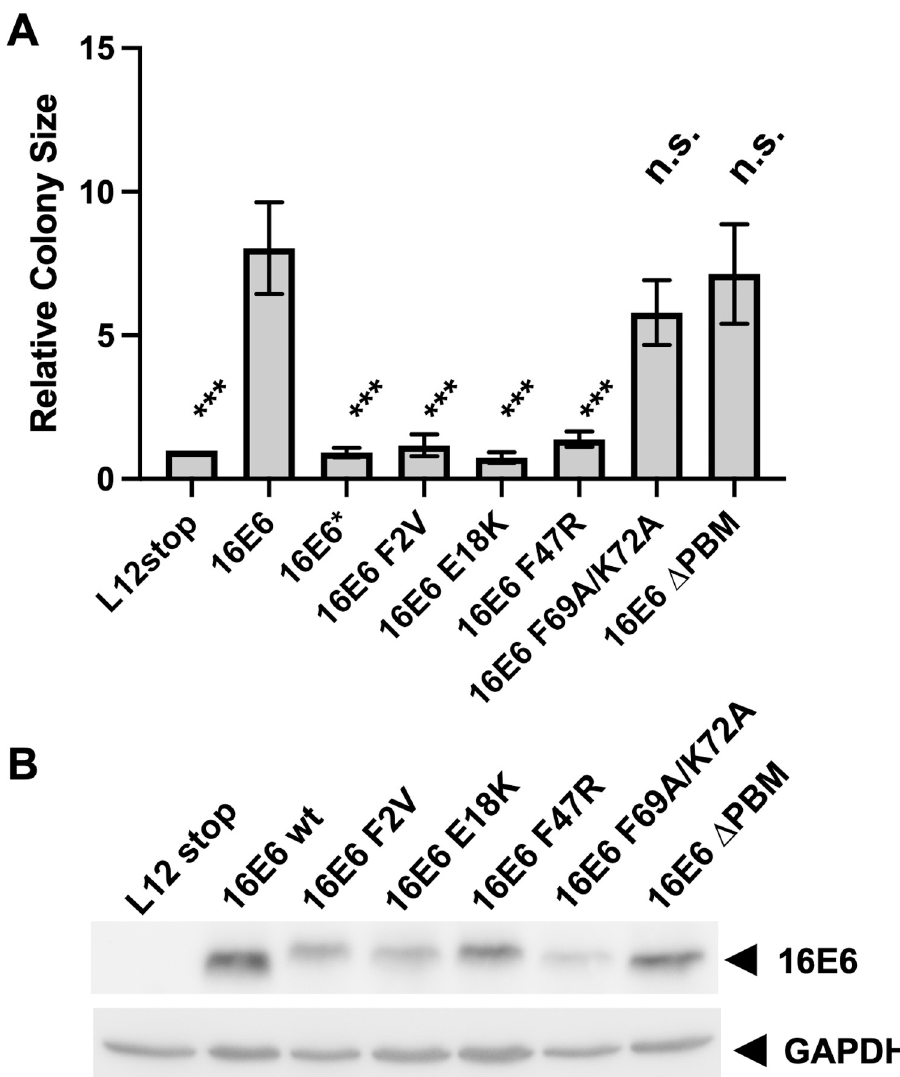
Fig 5. Mutational analysis of 16E6-induced cell colony competition. A. 16E6 mutations that interrupt interaction with p53 (F2V, E18K, F47R), NHERF1 (F69A/K72A), or PDZ-domain proteins ( Δ 150–151) were introduced into red NIKS keratinocytes and set into competition with green NKS keratinocytes as described in Fig 1. 16E6 with a stop codon at amino acid 12 served as the negative control and colony sizes are normalized to that sample. 16E6 with a stop codon at position 55 (E6 � , R55-stop) produces 16E6 � but cannot produce full length 16E6. The bar graph combines the results of 4 separate normalized experiments. ��� signifies P < 0.001, n.s. signifies non-significant differences. Fig 4B. Western blot analysis of 16E6 and mutant 16E6 protein expression. E6 � is not shown because it is not recognized by the 6G6 monoclonal anti-16E6